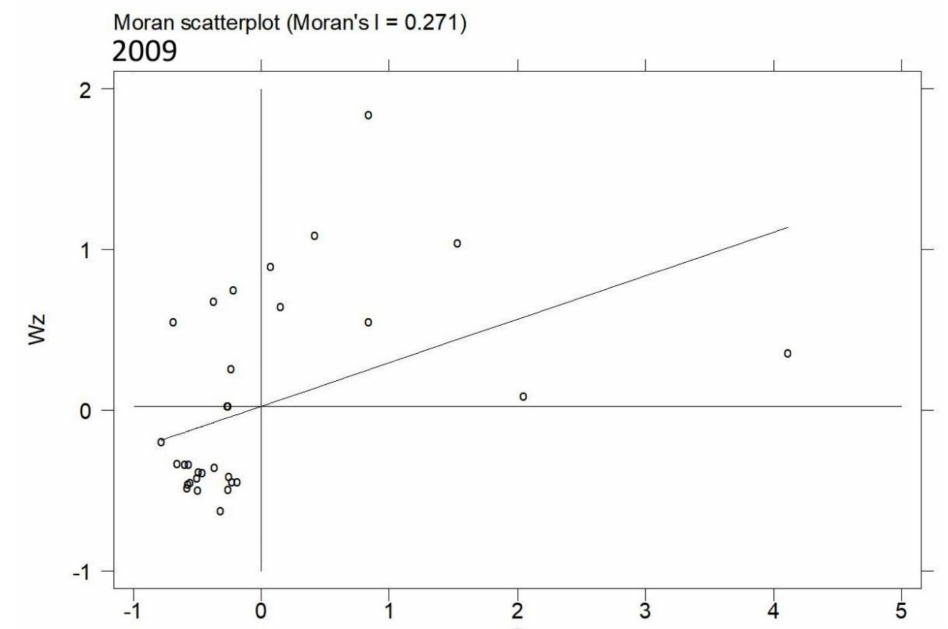
Figure 6. Moran scatterplot of the PCTLA s in the 31 Chinese provinces in